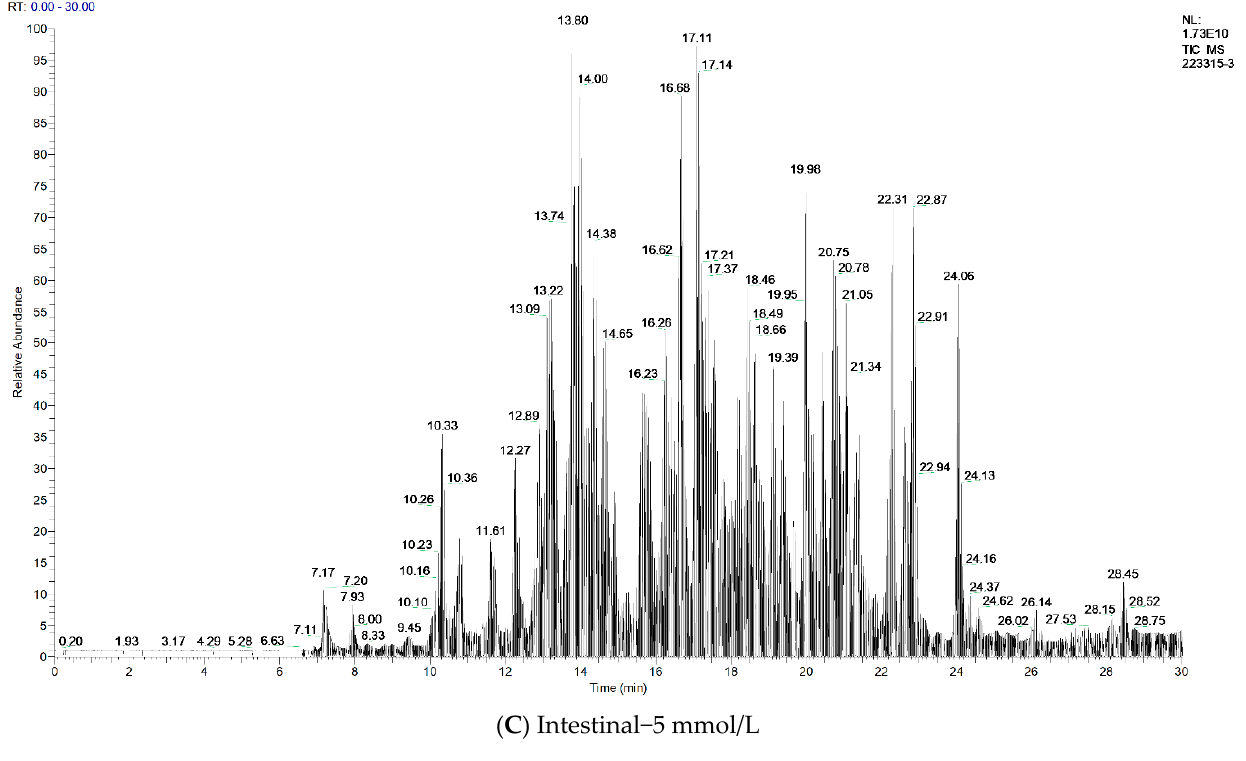
Figure 6. Total ions (X: time, Y: intensity) of walnut protein samples. ( A ) Sample of gastric digestion that is not oxidized; ( B ) sample of gastric digestion at the AAPH concentration of 5 mmol/L; and ( C ) sample of subsequent intestinal digestion at the AAPH concentration of 5 mmol/L. Table 2. The identification results of walnut protein digestion products (G − 0, G − 5, and I − 5) by